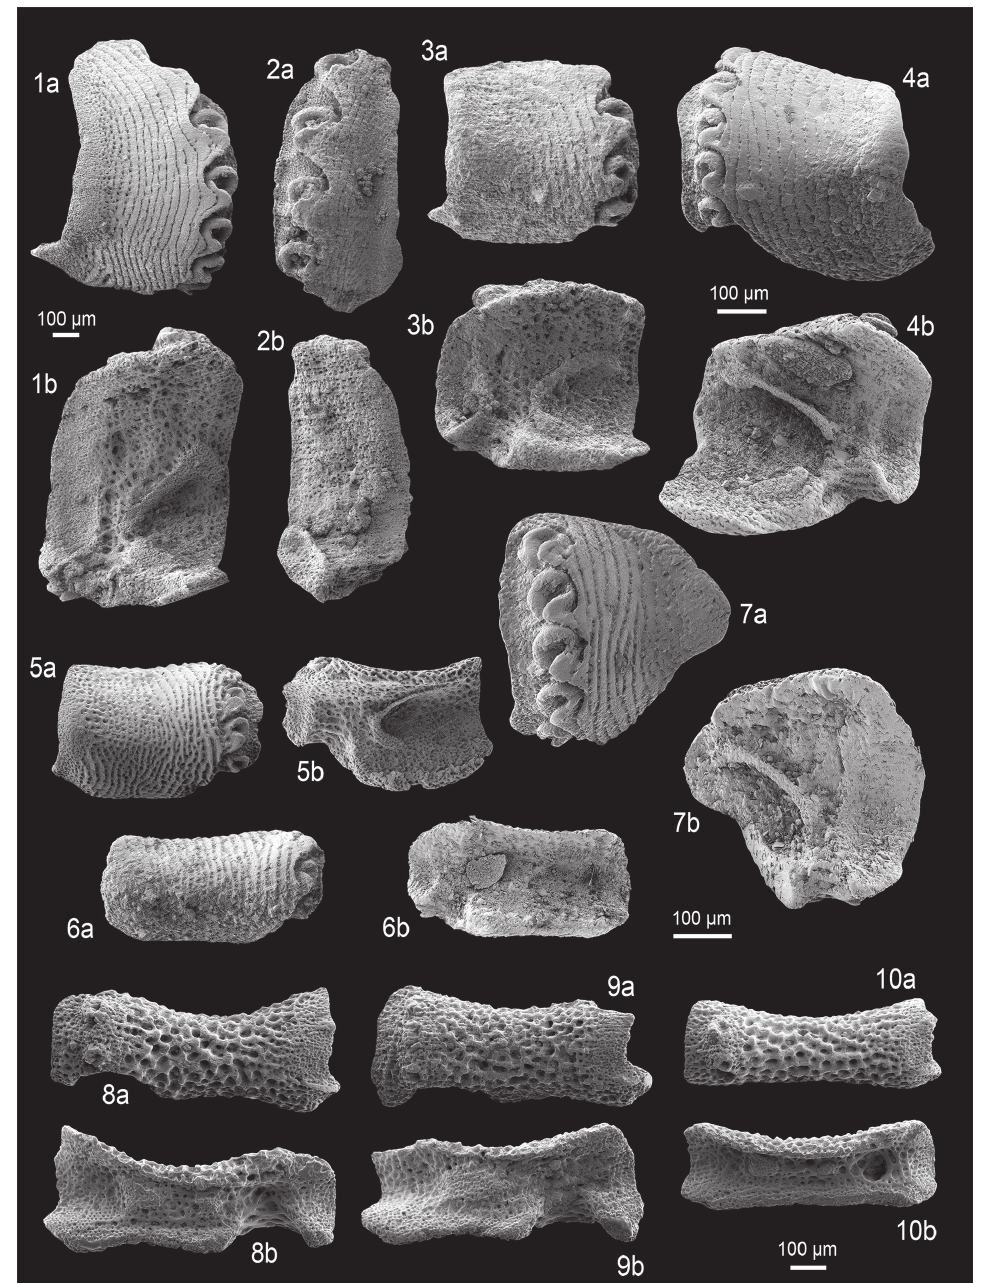
Fig. 14. Fossil lateral arm plates (LAPs) of ophiacanthid brittle stars in external (a) and internal (b) views. 1-3. Ophiolimna lisae sp. nov. from the early Kimmeridgian of the Pointe du Chay (1), France, and the late Kimmeridgian of Trancoso, Portugal (2-3). 1. GZG.INV.78561 (holotype), proximal LAP. 2. GZG. INV.78562 (paratype), proximal LAP. 3. GZG.INV.78563 (paratype), median LAP. 4-7. Ophiolimna kucerai sp. nov. from the latest Aptian to earliest Albian (Early Cretaceous) of Blake Nose, NE Atlantic. 4. GZG.INV.78566 (holotype), proximal LAP. 5. GZG.INV.78567 (paratype), median LAP. 6. GZG. INV.78568 (paratype), distal LAP. 7. GZG.INV.78569 (paratype), proximal LAP. 8-10. Geromura touertensis gen. et sp. nov. from the Bajocian-Bathonian boundary of Touert, France. 8. GZG.INV.78571 (holotype) median to proximal LAP. 9. GZG.INV.78572 (paratype), proximal LAP. 10. GZG.INV.78573 (paratype), distal LAP. One common scale bar per species is